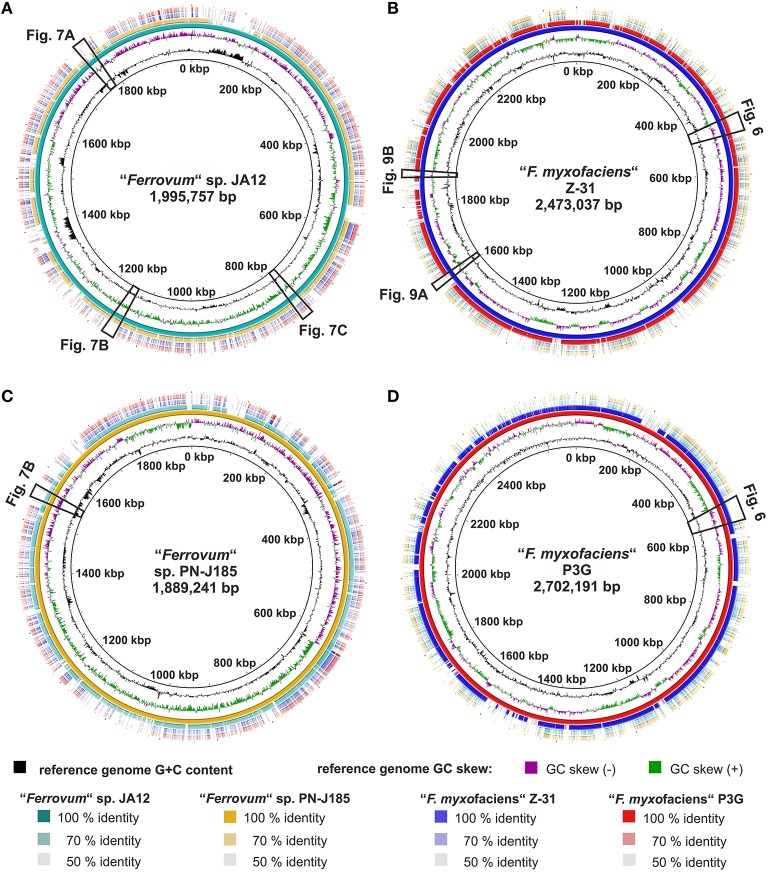
Reference-based whole genome comparison of the four “Ferrovum” strains. Blastn-based whole genome comparison and visualization were performed using BRIG (Alikhan et al., 2011) with each of the four genomes used as a reference in turn. The reference genome and its size are indicated in the figure center: (A) group 2 strain JA12, (B) “F. myxofaciens” Z-31, (C) group 2 strain PN-J185, (D) “F. myxofaciens” P3G. For the reference genome also G+C content and GC skew are shown on the first and the second ring from the inside. Circular representation of the reference genomes (third ring) is based on the concatenation of the contigs. Contigs of group 2 strain JA12 were ordered FERRO_contig000001 to FERRO_contig000003 (LJWX01000001 to LJWX01000003), while contigs of the other strains were ordered randomly. Matches to the reference genomes are displayed color-coded (JA12, turquoise; PN-J185, orange; Z-31, blue; P3G, red) on the rings four to six. The levels of the match sequence identities are indicated by color intensity (the higher the color intensity the higher the sequence identity). Cross references link to other figures showing a more detailed analysis of regions of interest.